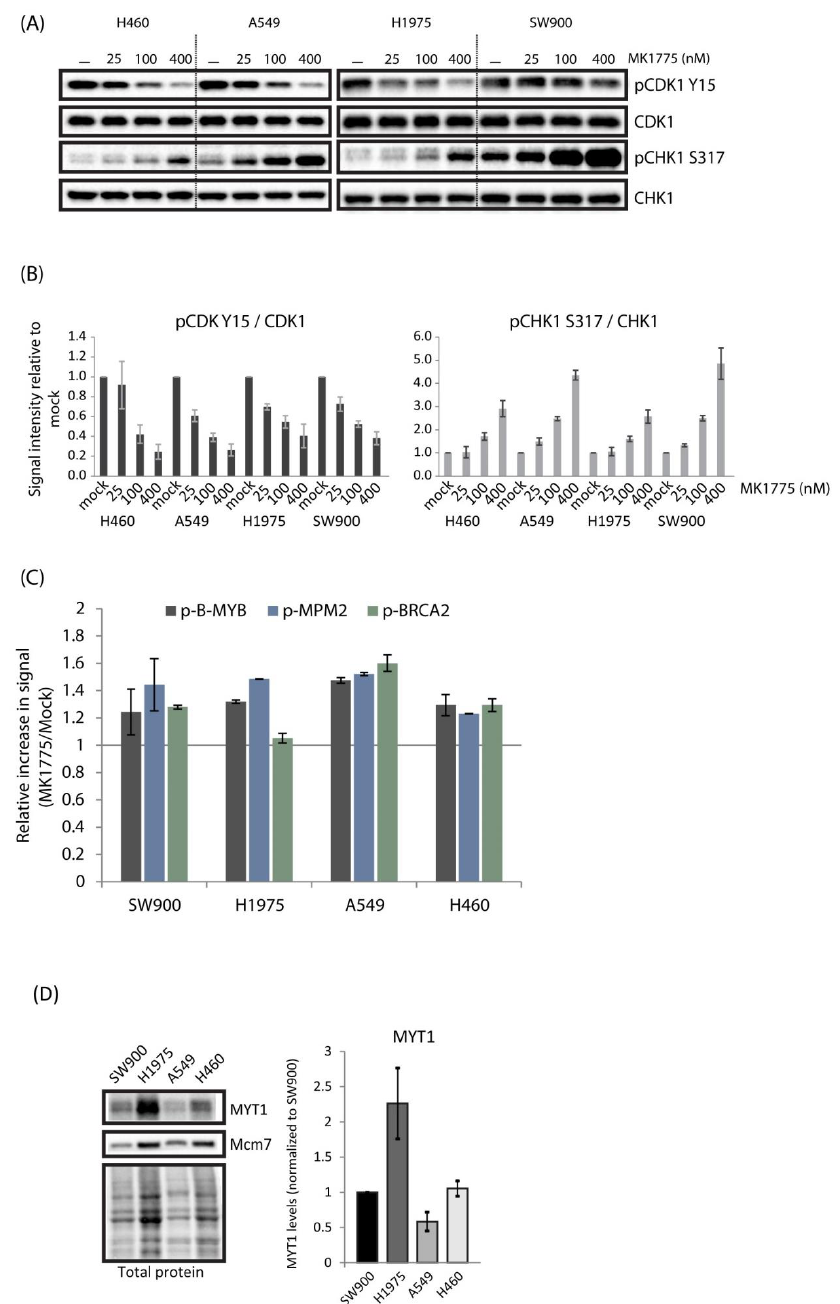
Figure 3. MK1775 increases CDK activity and CHK1 phosphorylation in lung cancer cell lines. ( A ) Immunoblotting of extracts from H460, A549, H1975, and SW900 cells treated with 0, 25, 100, and 400 nM MK1775 for 1 h. ( B ) Quantification of results from experiments as in A. Error bars: SEM (n = 3). ( C ) Flow cytometry analysis of phospho-B-MYB, phos-